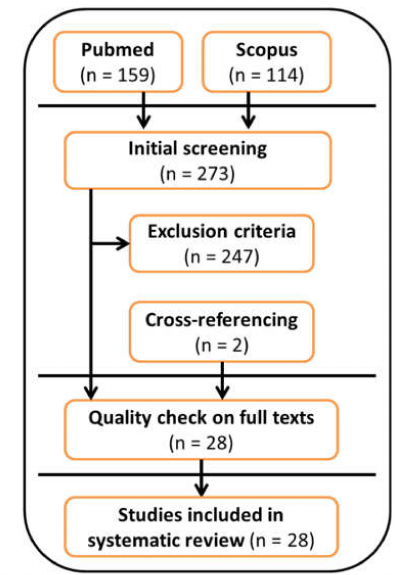
Figure 1. Flowchart of the systematic review